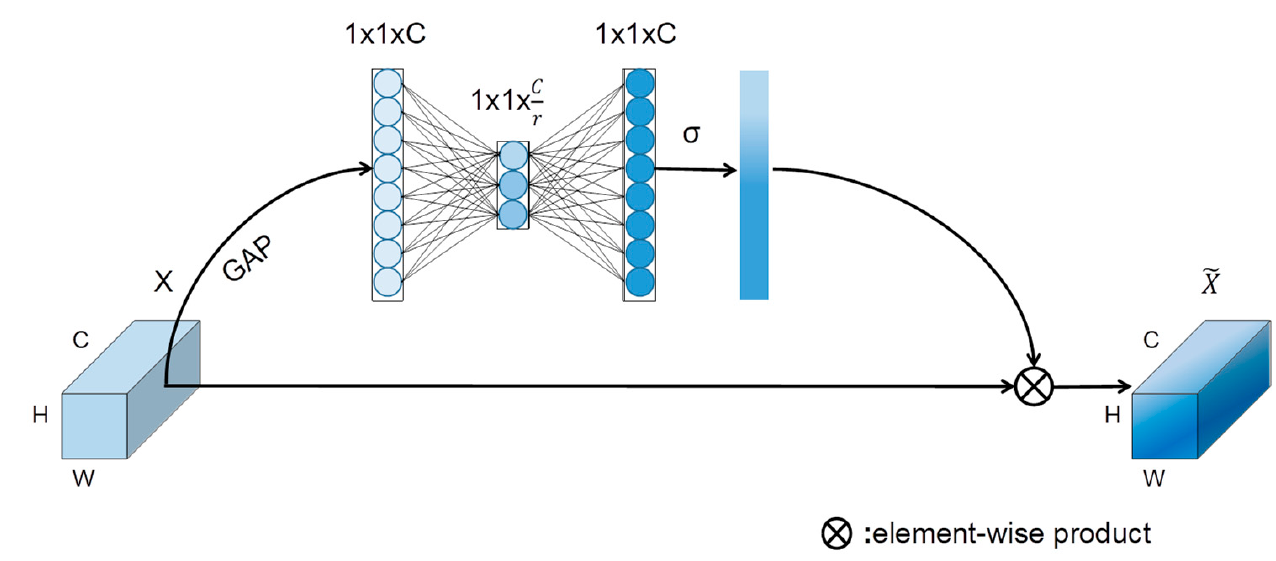
Figure 1. Channel a tt ention module SE. Figure 1. Channel attention module